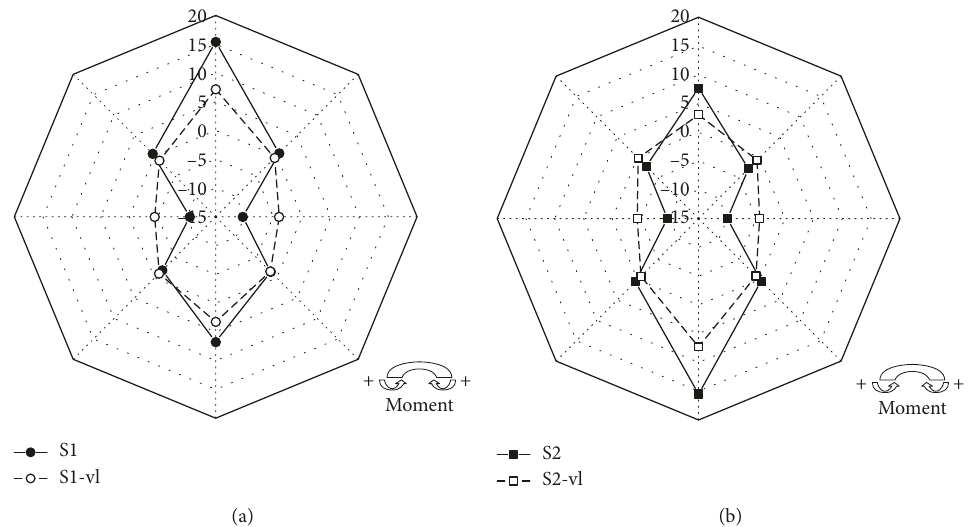
Figure 11: Transverse bending moments (kN · m/m) induced on the lining of the existing tunnel at the end of tunnel excavation of (a) S1 and (b) S2.